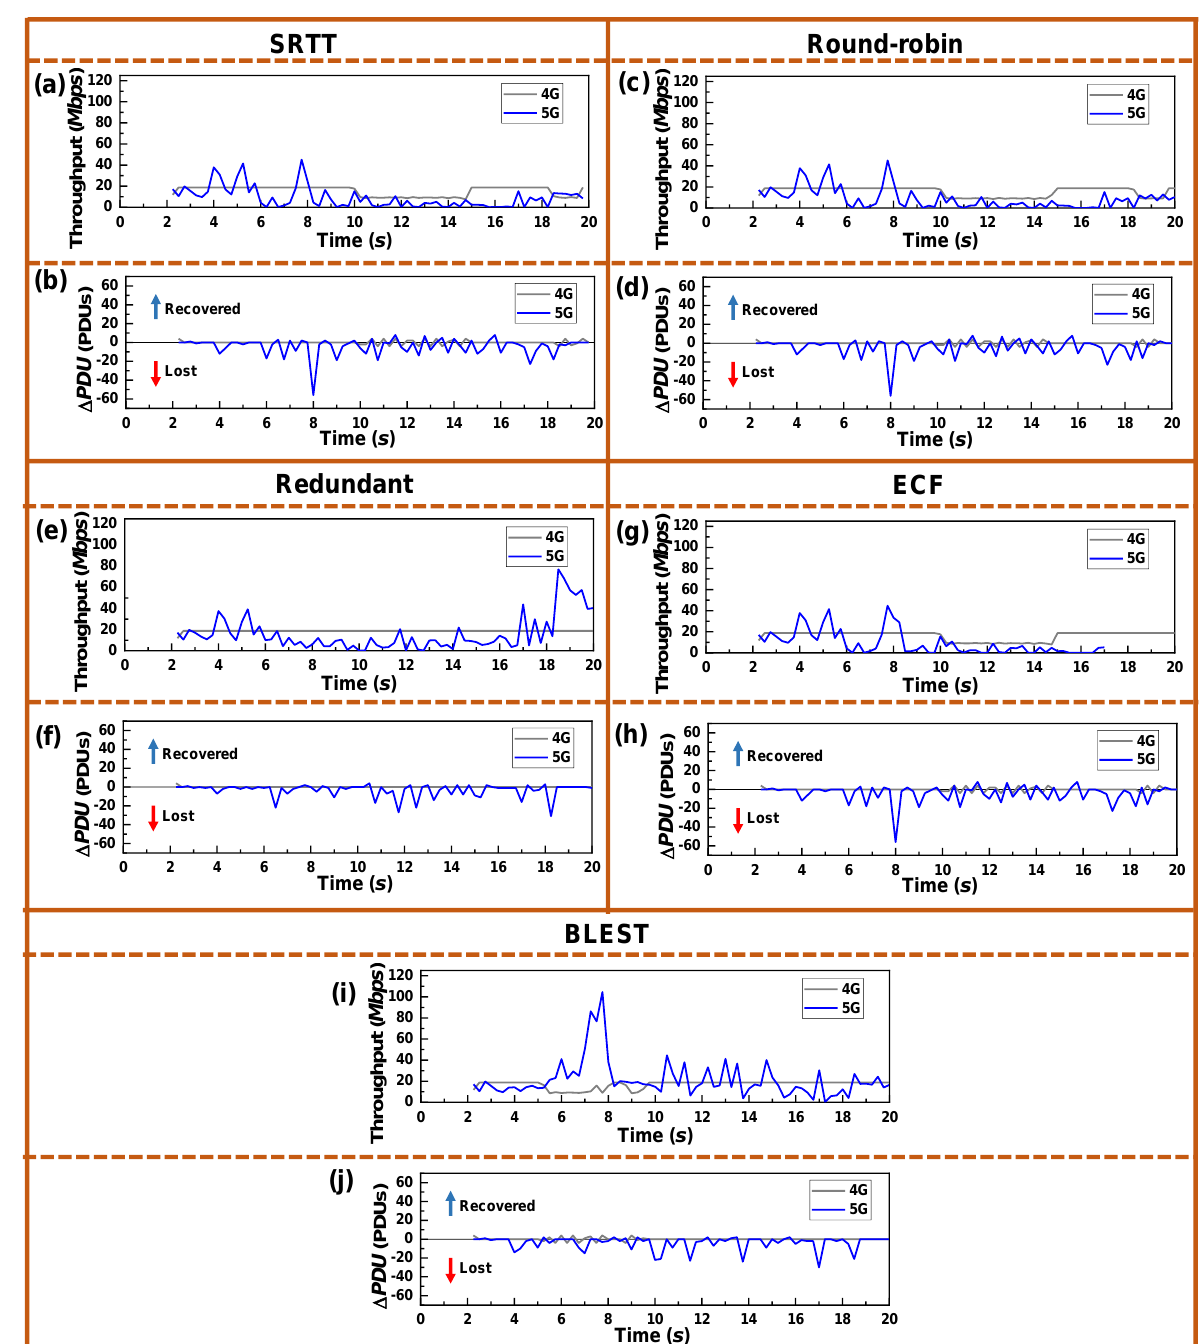
Figure 5. Real-time performance of the tested MPTCP schedulers for LIA as a CCA in terms of throughput and ∆ PDU for: ( a , b ) SRTT, ( c , d ) Round-robin, ( e , f ) Redundant, ( g , h ) ECF, and ( i , j ) BLEST,